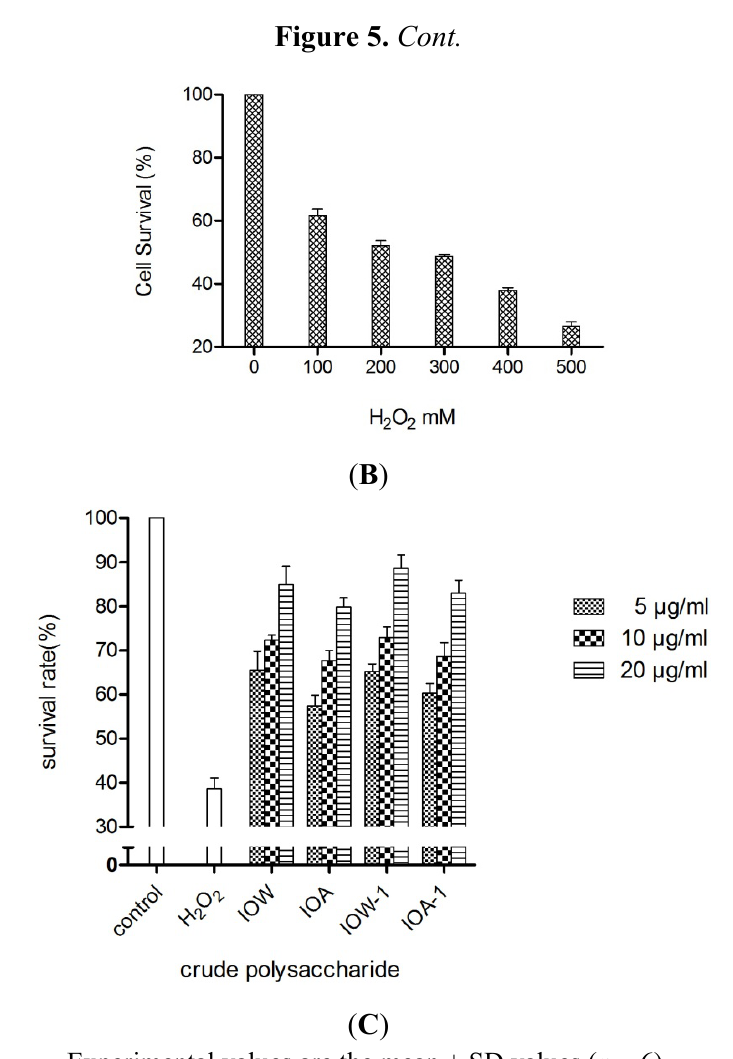
Experimental values are the mean + SD values ( n =